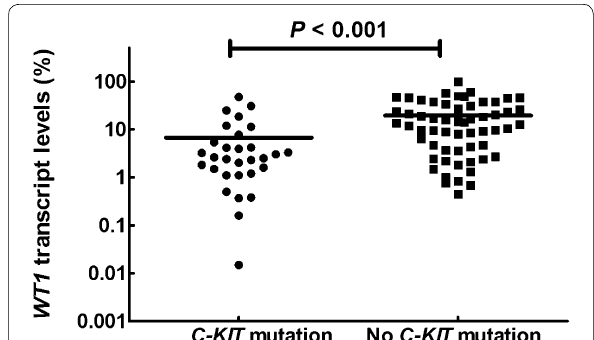
Fig. 1 Patients with a cellular homolog of the viral oncogene v‑KIT receptor tyrosine kinase ( C ‑ KIT ) mutation had significantly lower Wilm tumor gene‑1 ( WT1 ) transcript levels at diagnosis than patients who did not have a C ‑ KIT mutation. Line represents median WT1 transcript